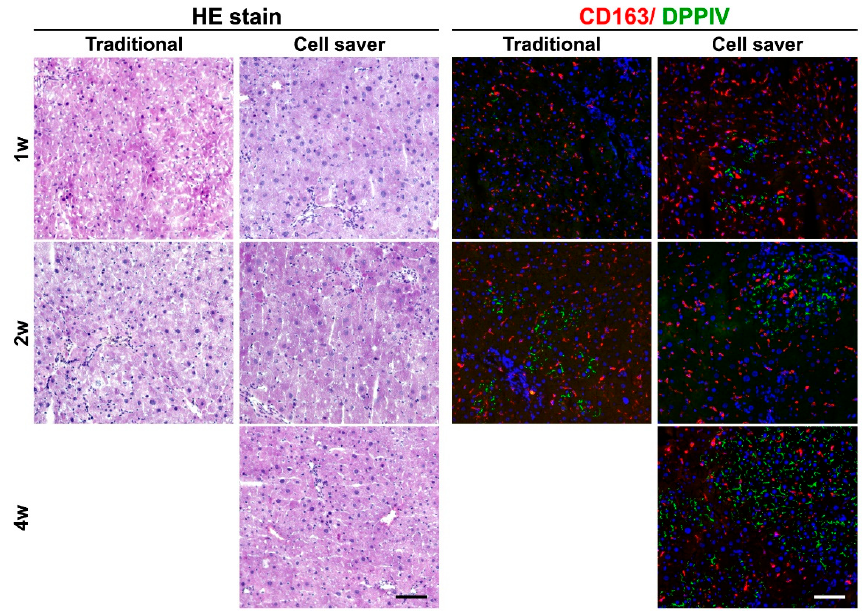
Figure 6. Recovery of liver histology and inflammation after hepatocyte transplantation for acute liver injury. Histological integrity and evenly-distributed macrophage (CD163 + ) could be observed at 2 weeks in both groups. Scale bar: 100 μ m.